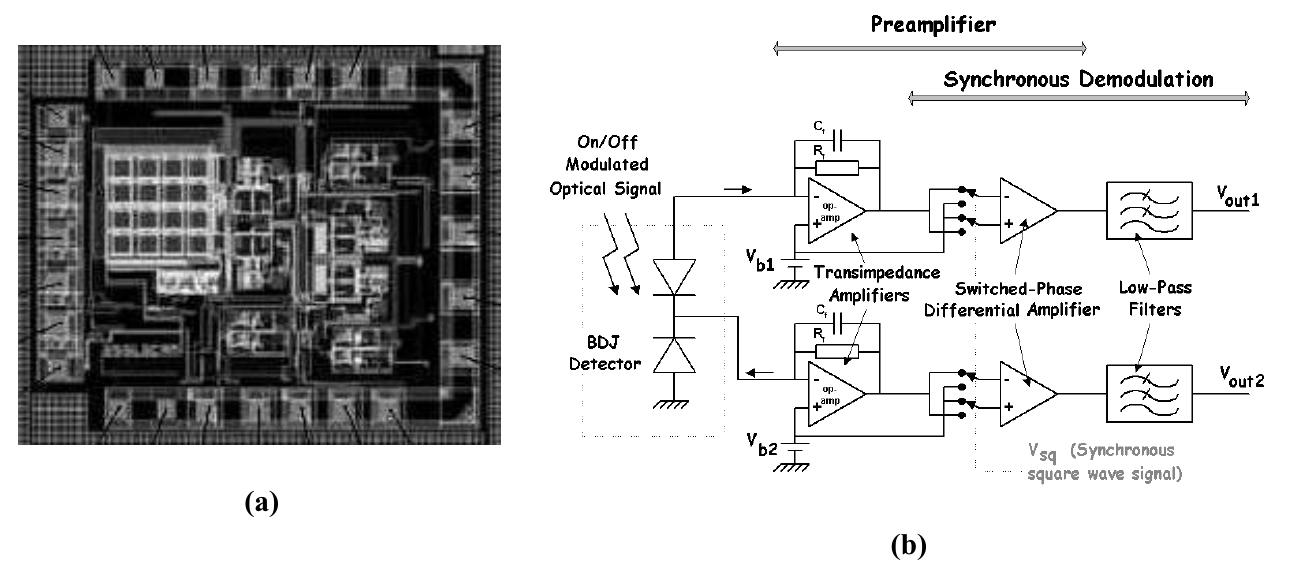
Figure 21. (a) Chip integrating an array of 4 x 4 BDJ pixels: (b) on-chip charge / transimpedance preamplifier and synchronous detection [112,